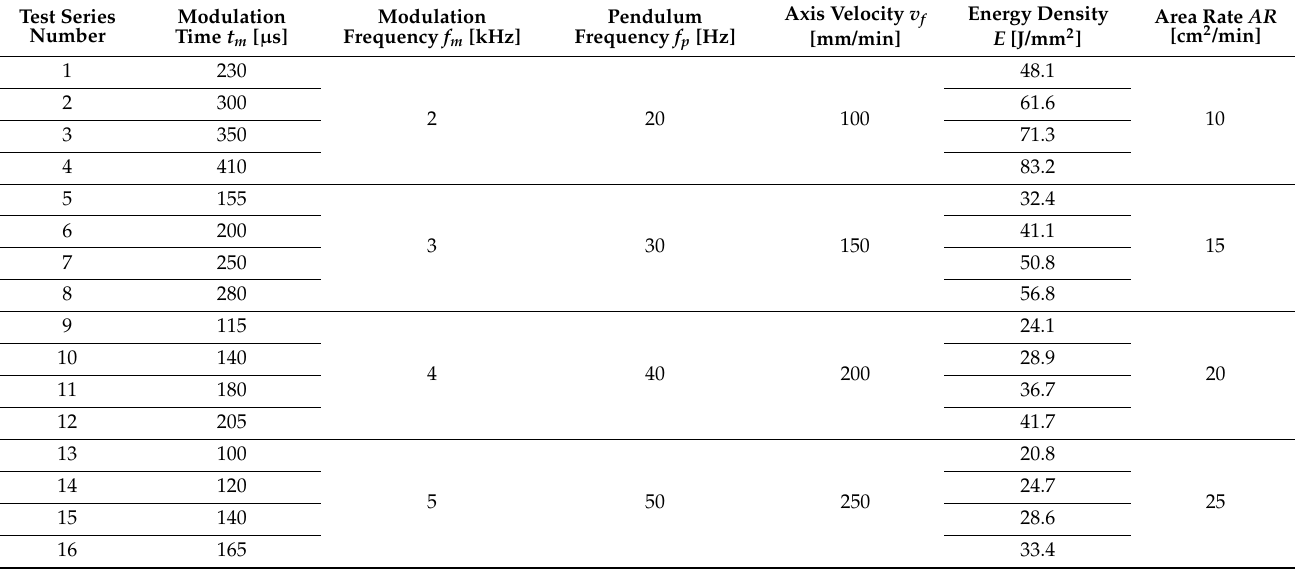
Table 5. Experimental plan of the basic process parameter investigations with modulated laser power. Test Series